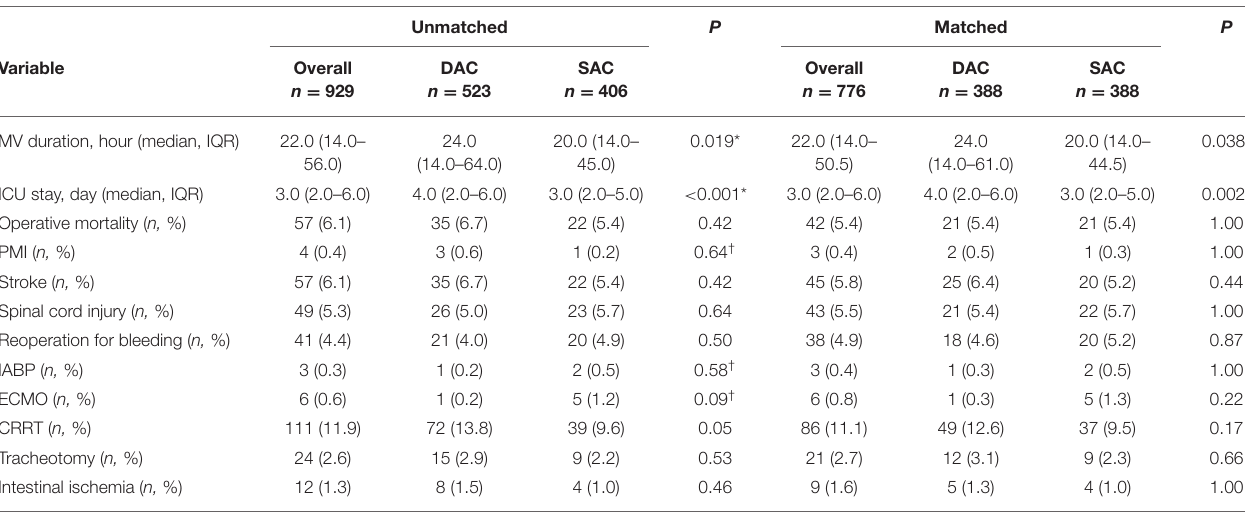
TABLE 3 | Perioperative outcome